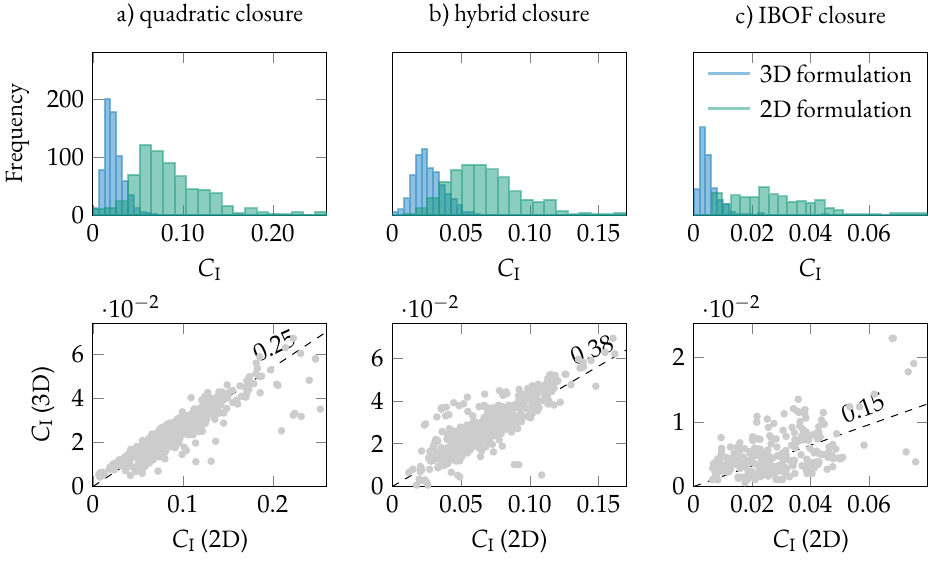
Figure 7. Distribution of Folgar Tucker parameters among all simulations for the 2D and 3D formula- tion of the Folgar Tucker